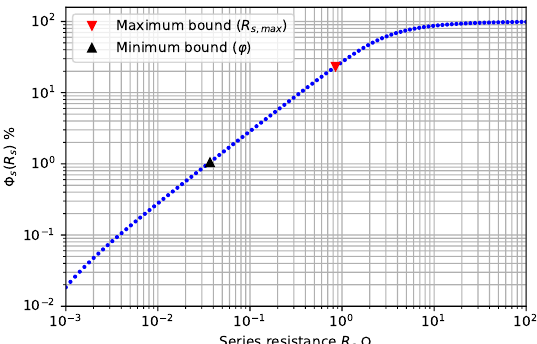
Figure 5. Behavior of Φ s ( R s ) for a test SPVM. The minimum and maximum boundaries are